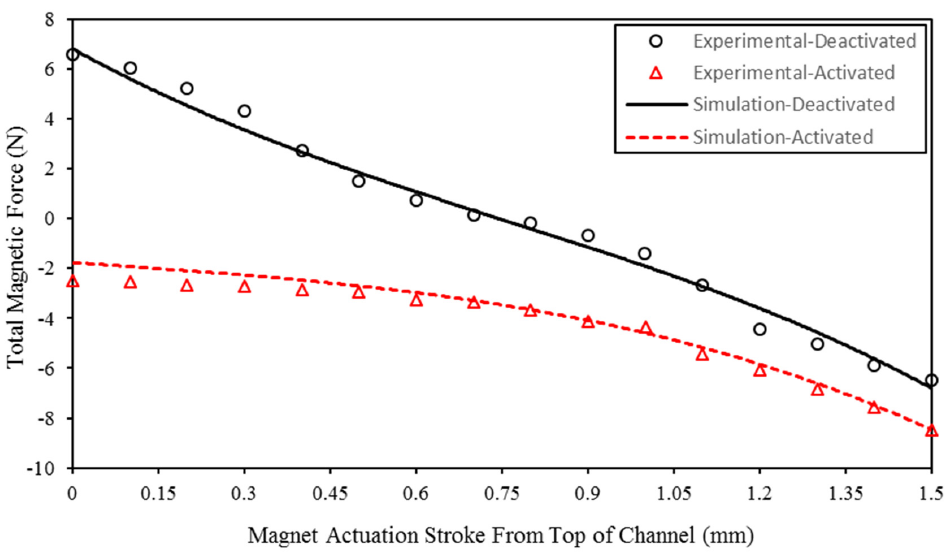
Figure 17. Total magnetic force on the permanent magnet along the actuation stroke of the optimised actuator.